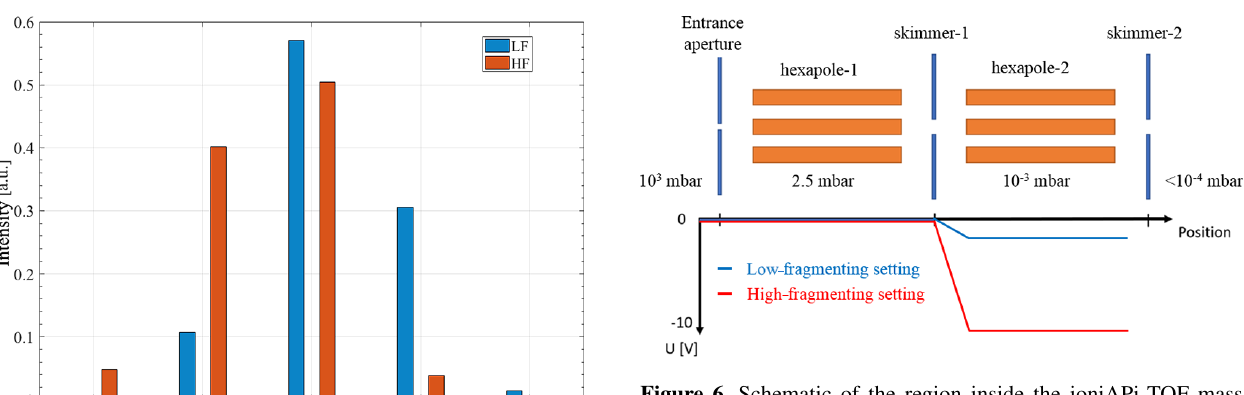
Figure 6. Schematic of the region inside the ioniAPi-TOF mass spectrometer where fragmentation was studied in this work. Here, a low-fragmenting clustered setting and a high-fragmenting declus- tering setting can be used to identify cluster ions and to study their stability by adjusting the voltage difference (dV) between skimmer- 1 and